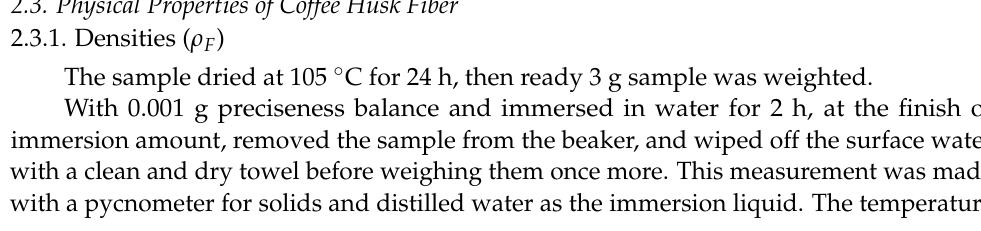
Figure 1. Coffee husk fiber preparation process.